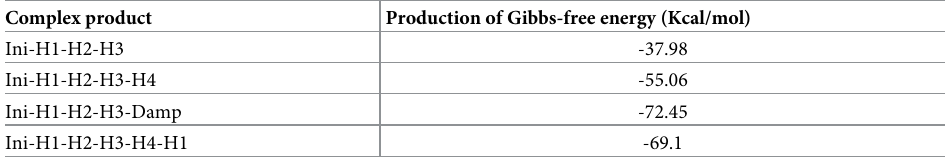
Table 1. The change in Gibbs-free energy for the different complex